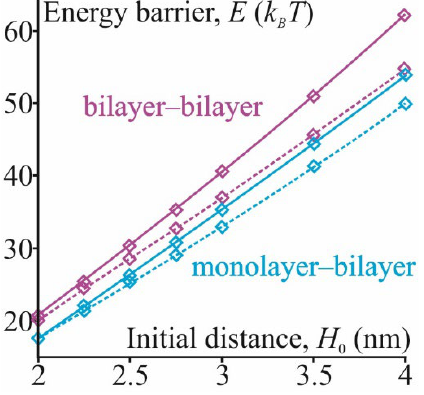
Figure 5. Dependence of energy barriers E and E bil (in k B T ) on the initial distance H 0 for the cases of Js = –0.1 nm –1 , P 0 = 800 k B T /nm 3 and ξ h = 0.235 nm and Js = –0.25 nm –1 , P 0 = 60 k B T /nm 3 and ξ h = 0.37 nm. The first set of parameters model the pure DOPC membrane, and the second, the mixture of DOPC:DOPE = 1:1. Barriers are depicted as follows: cyan color solid line—bilayer–monolayer fusion, pure DOPC; cyan color dashed line—bilayer–monolayer fusion, DOPC:DOPE = 1:1; purple color solid line—bilayer fusion, pure DOPC; and purple color dashed line—bilayer fusion, DOPC:DOPE = 1:1.